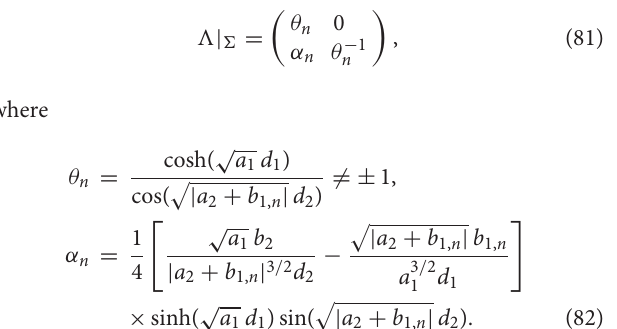
a 1 , = a 2 b 1 , V 2,2 a 2 b 1 b 2 = + = + + b 2 = =